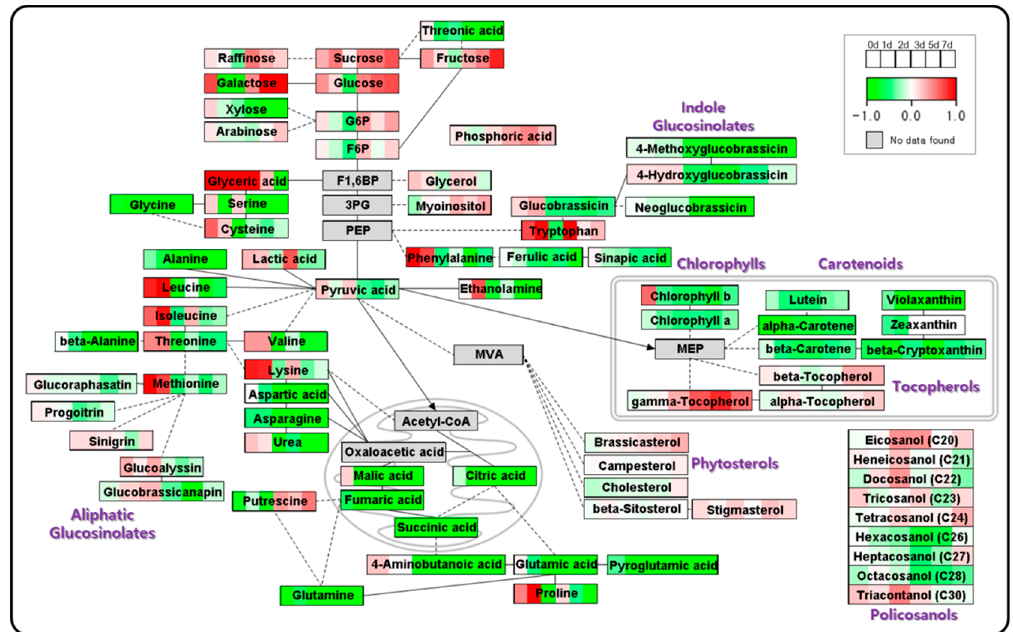
Figure 4. Metabolite change data mapped onto the schematic pathway of radish sprouts growth. The log 2-fold change (log 2 FC) values of metabolite levels in radish sprouts grown under nitrogen deficient condition relative to those under nitrogen sufficient condition on each day. The log 2 FC values are represented as a gradient and can be visualized per box on the top right (increased abundance is shown in red and decrease in abundance is shown in green). The gray boxes represent the metabolites that could not be detected. The solid-lines represent a direct link and dotted-lines represent an indirect link between the metabolites. The solid-line arrows show the transfer of metabolites to cell organelles. G6P, Glucose 6-phosphate; F6P, Fructose 6-phosphate; F1,6BP, Fructose 1,6-bisphosphate; 3PG, 3-Phosphoglyceric acid; PEP, 2-Phosphoenolpyruvate; MEP, Mevalonate; MVA, Mevalonic acid; DAI, day after light incubation began.